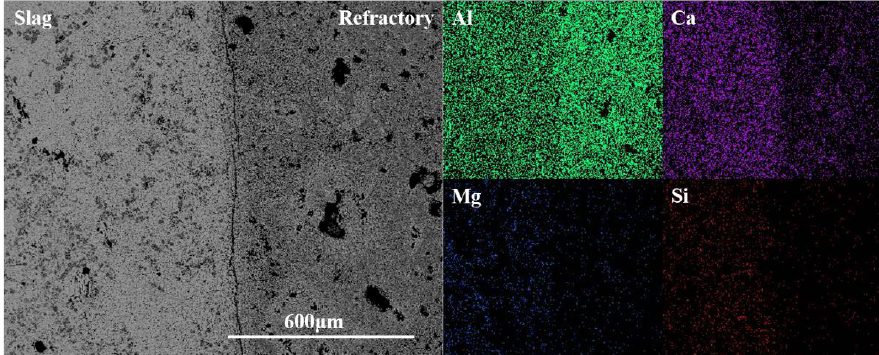
Figure 4. Element mapping of the slag-crucible interface of CA 6 crucible.